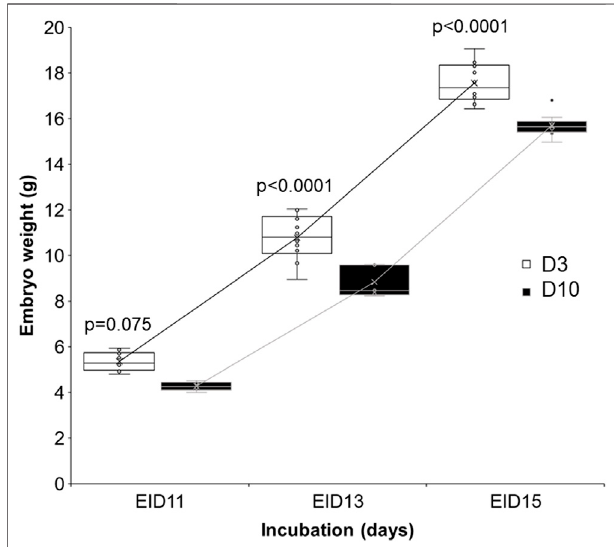
FIGURE 7 | Effect of storage time on embryo weight after 11, 13 and 15 days of incubation. D3 and D10 eggs were opened at EID11, EID13 and EID15 after CT or MRI analyses and weighed. Statistical analysis was performed using one-way ANOVA with p < 0.05.